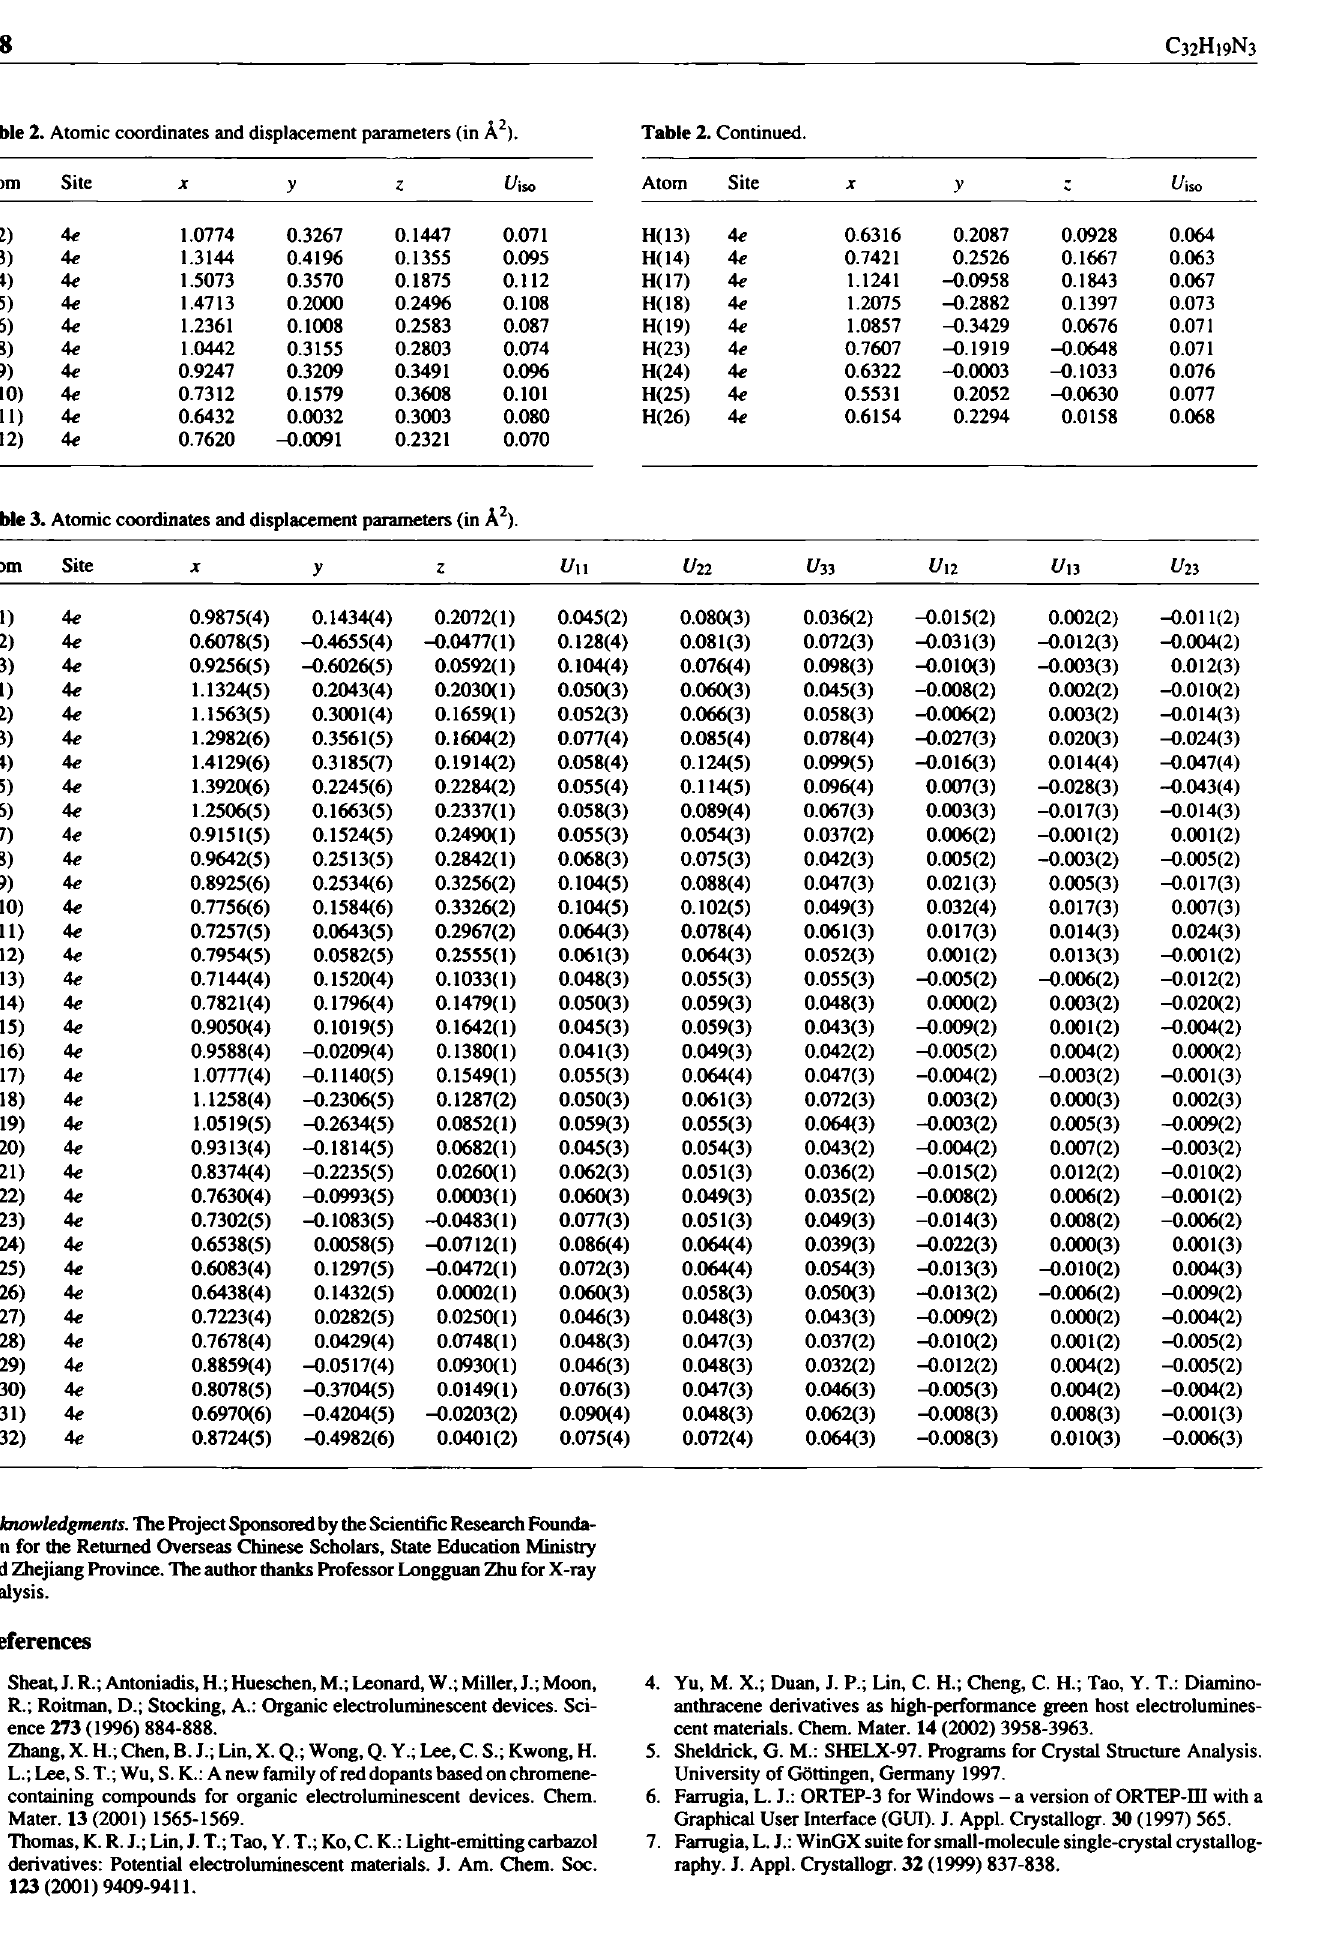
Table 2. Atomic coordinates and displacement parameters (in Â 2 ).